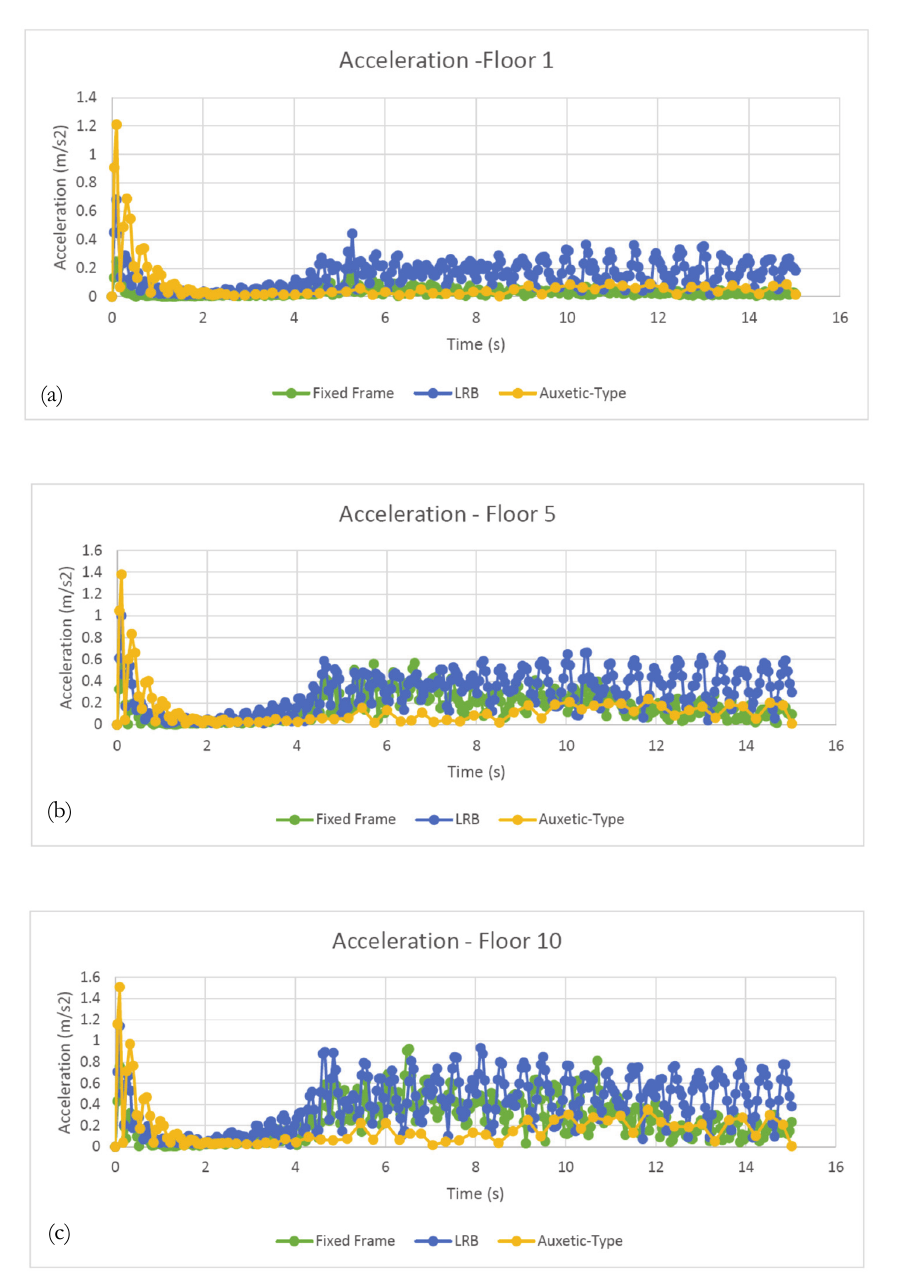
Figure 14: Acceleration on floor (a) 1, (b) 5, (c)